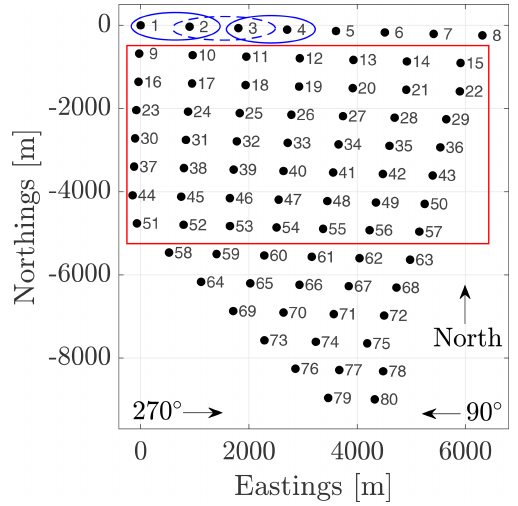
Figure 1. Layout of GT I. Each wind turbine is labelled with its corresponding number. The spacing of the wind turbines is inho- mogeneous. The wind directions 90 and 270 ◦ (marked in the fig- ure) are analysed in detail in subsequent sections. The red square depicts the set of wind turbines that are used during the location- dependence analysis in Sect. 3.2 due to their symmetric arrange- ment. In the clustering analysis in Sect. 4, the whole wind farm is used. The blue ellipses exemplarily show the definition of the con- sidered wind turbine pairs. Table A1 lists the definition of all